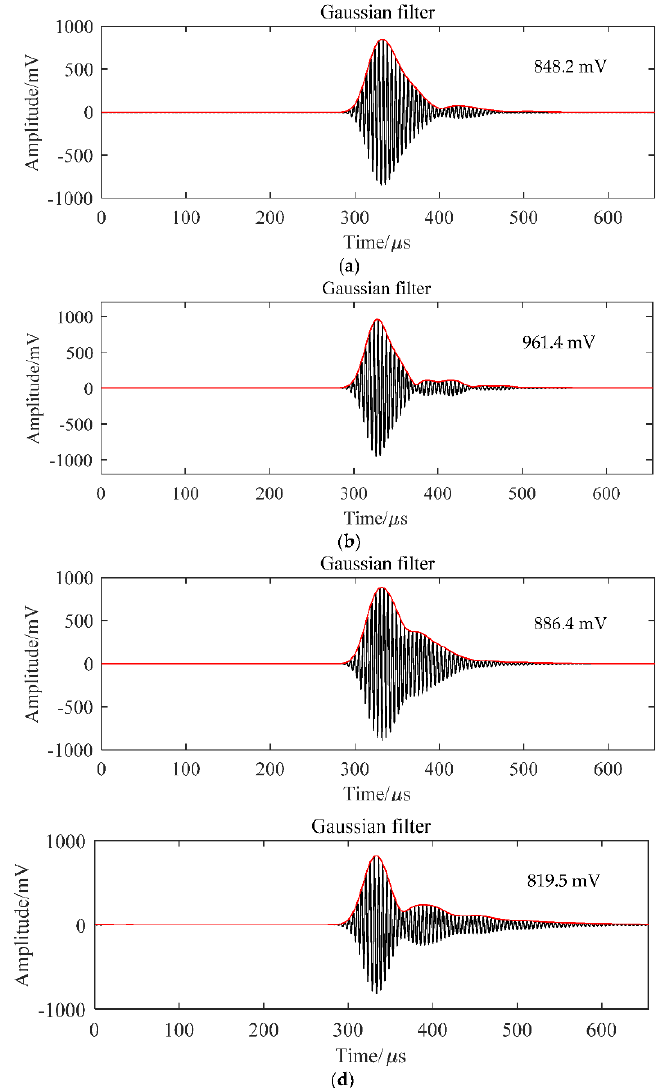
Figure 6. Time–domain filtered and enveloped signal of ( a ) BR20-15-15, ( b ) BR20-19-15, ( c ) BR20-15-15, and ( d ) transducer from Japan Probe Co., LTD.